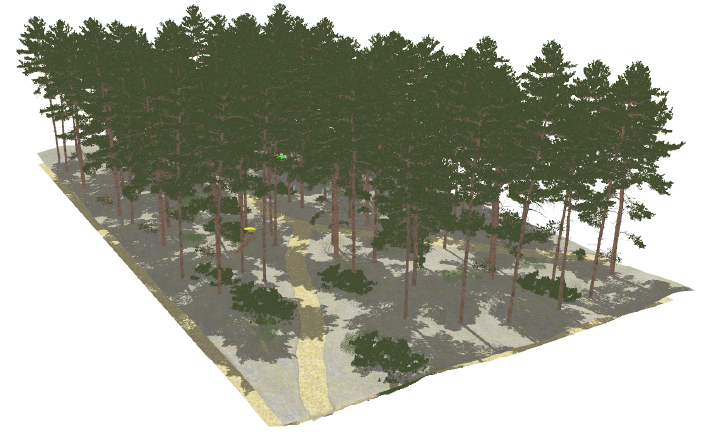
Figure 6. The dense forest environment modeled in Gazebo.